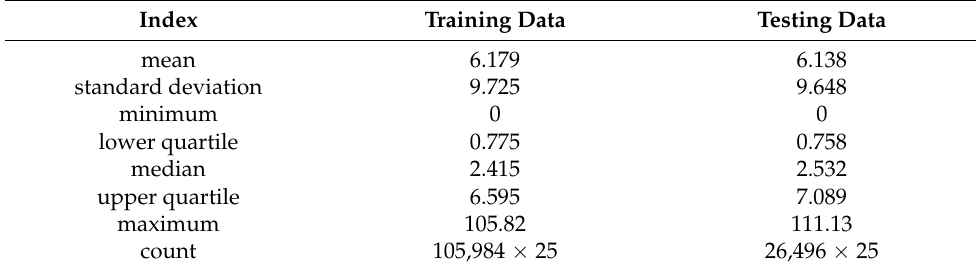
Table 2. Descriptive analysis of the sample